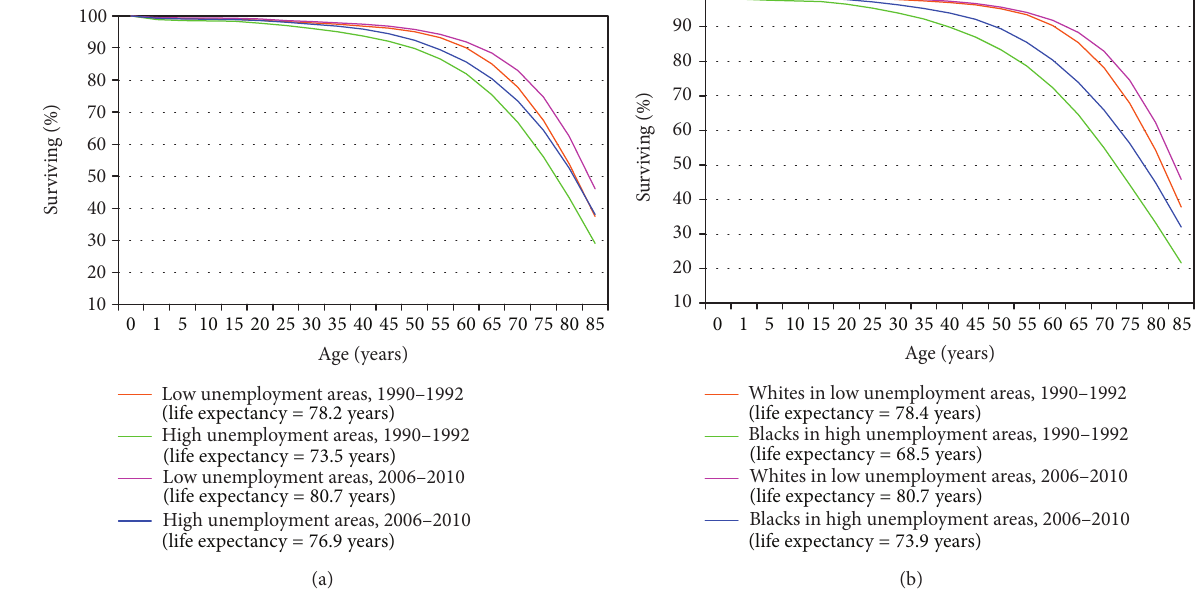
Figure 2: Survivorship by age, race, and unemployment level, United States,